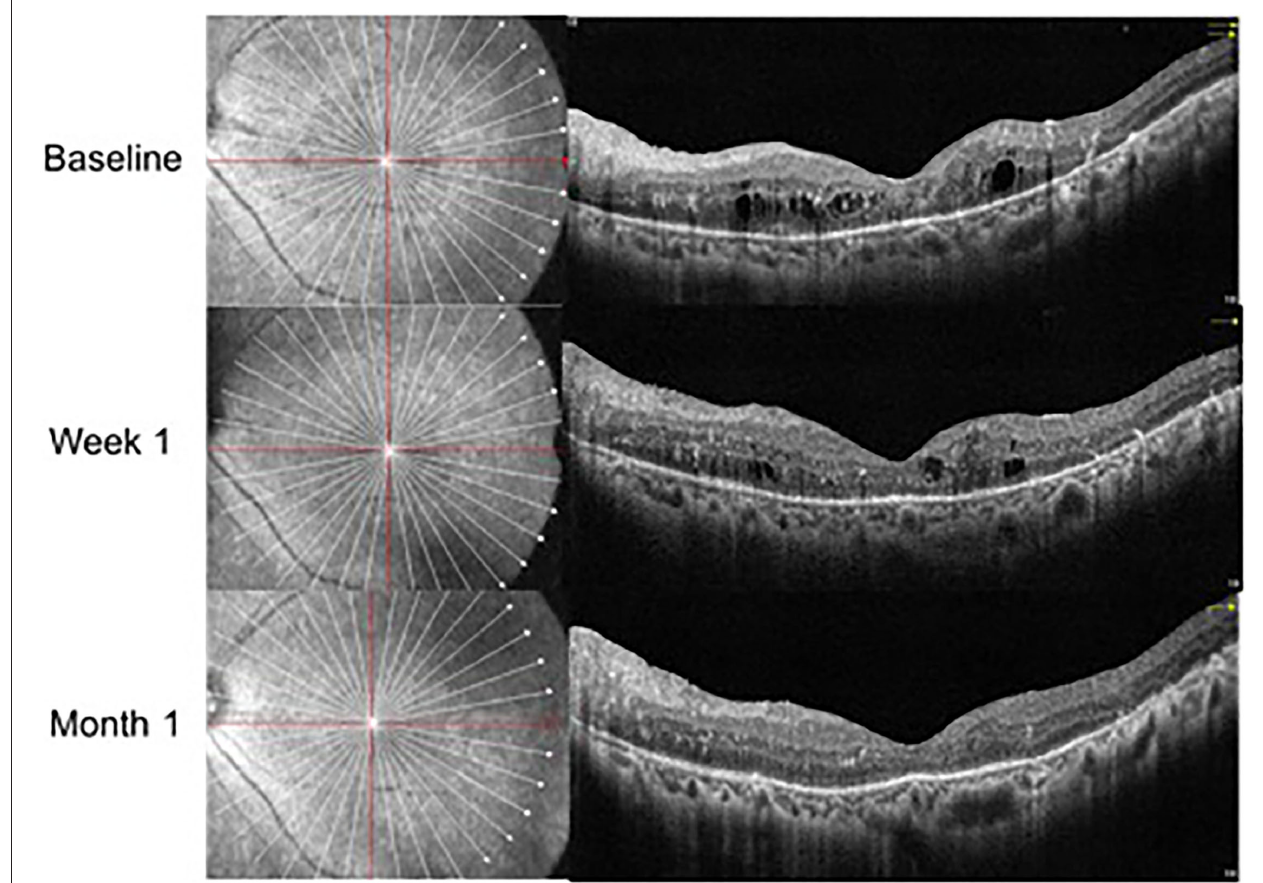
FIGURE 2 | OCT follow-up visit of the same patient with Ozurdex treatment.